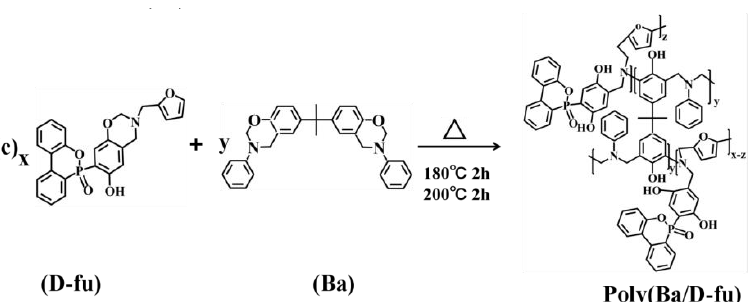
Figure 2. The ideal chemical structure and curing schematic diagram of ( a ) D-fu, ( b ) Ba and ( c ) the crosslinking reaction of D-fu and Ba.